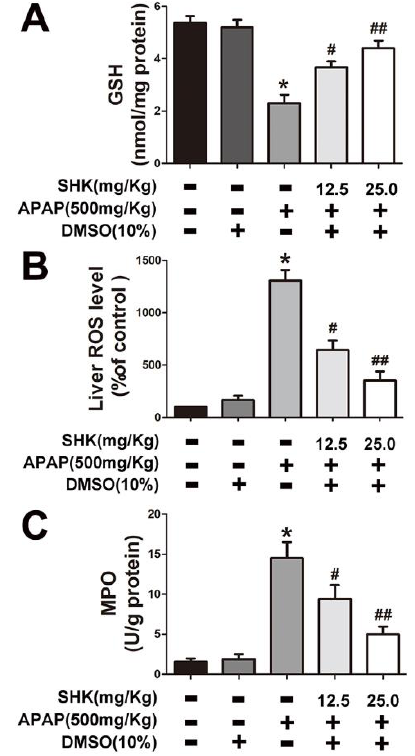
Figure 2. Effects of SHK treatment on APAP-induced glutathione (GSH), reactive oxygen species (ROS) and myeloperoxidase (MPO) production in mice. Mice were injected with SHK (12.5 and 25 mg/Kg) for 1 h, and then injected with APAP (500 mg/Kg) for 9 h. ( A ) The effect of SHK on liver GSH production in APAP-treated mice. ( B ) SHK reduced the accumulation of APAP-induced ROS in liver. ( C ) SHK inhibited APAP-induced MPO production in liver. All of the data shown represent the average from five independent experiments. * p < 0.05 versus the control group; # p < 0.05 and ## p < 0.01 versus the APAP group.